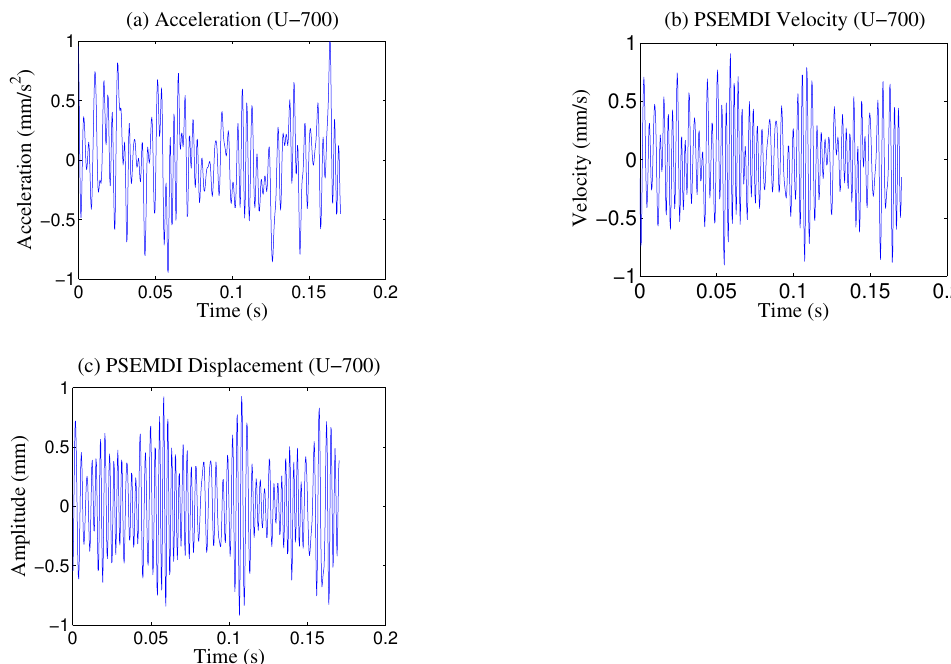
Figure 12. Results of the PSEMDI method for Case 1 at 700 rpm: ( a ) Signal; ( b ) velocity; ( c )